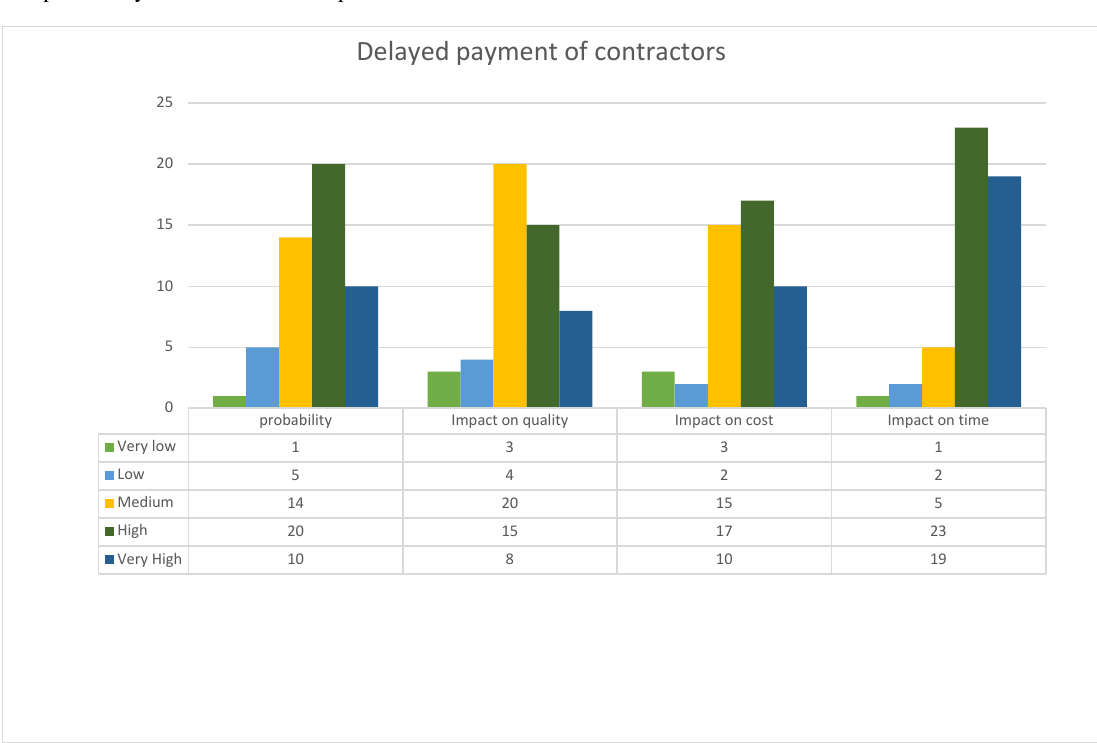
Fig. 5. Sample survey results (delayed payments to contractors) Fig. 5. Alt Text: Sample survey results (delayed payments to contractors), Where the majority chose that the impact